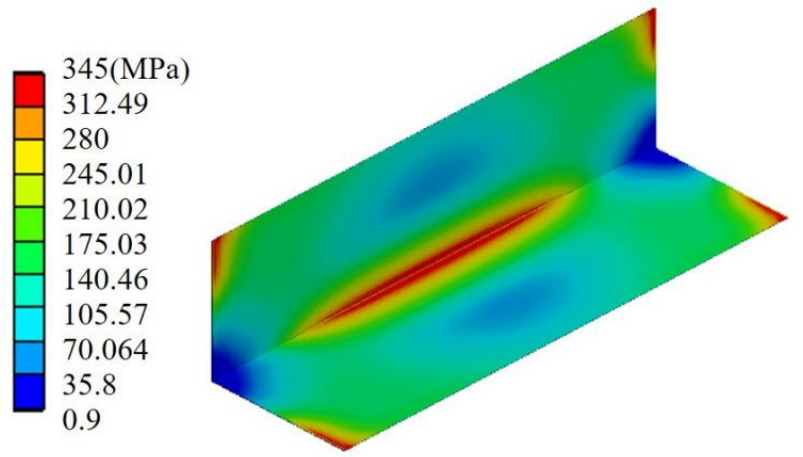
Figure 4. Contours of the von Mises stress distribution of connected plates without ribs.